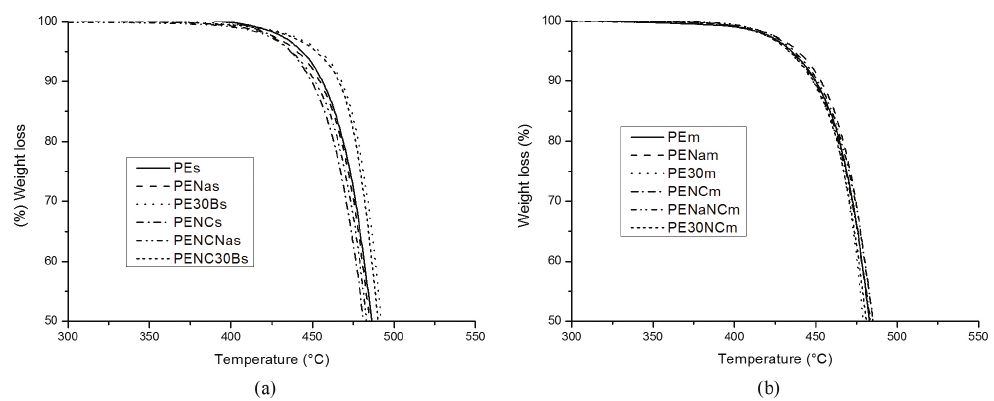
Figure 5. TGA thermograms for nanocomposites mixing by (a) solution; (b) melting. Table 3. Data obtained from TGA analysis of nanocomposites for different mixing process.